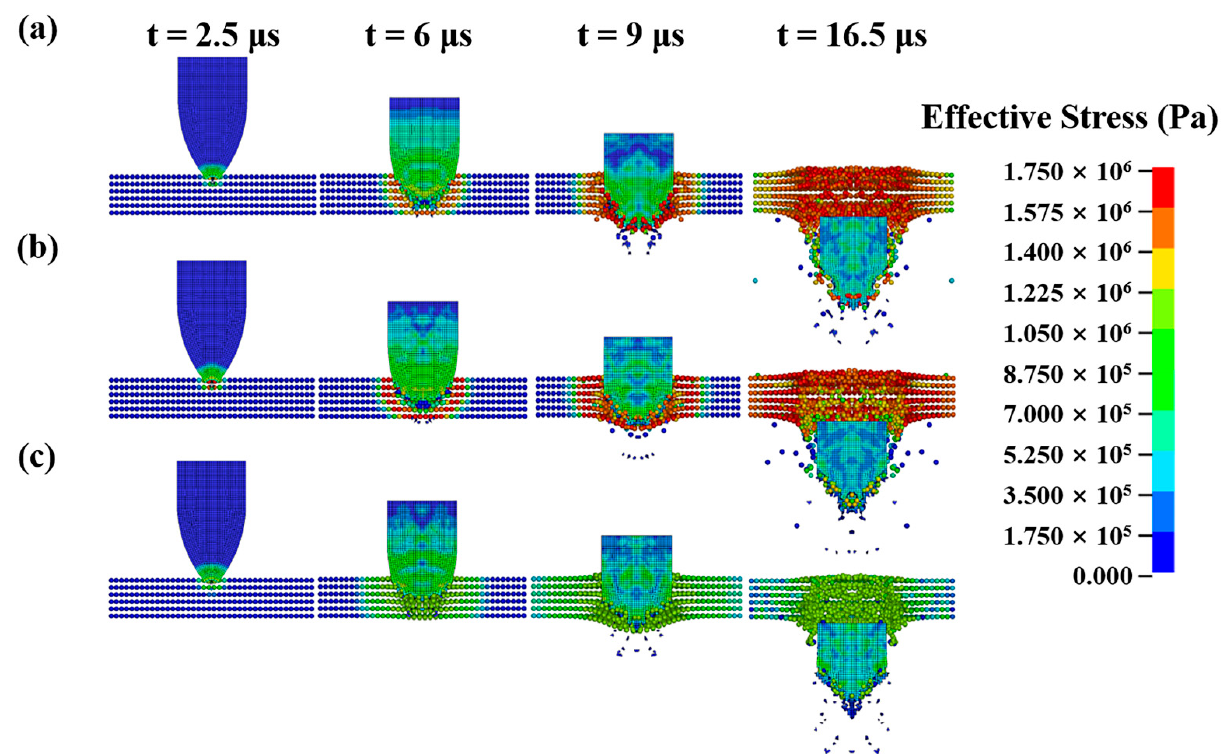
Figure 2. Equivalent stress diagram of bullet penetration process of different alloys ( a ) depleted uranium alloy; ( b ) tungsten alloy; ( c ) high strength steel.